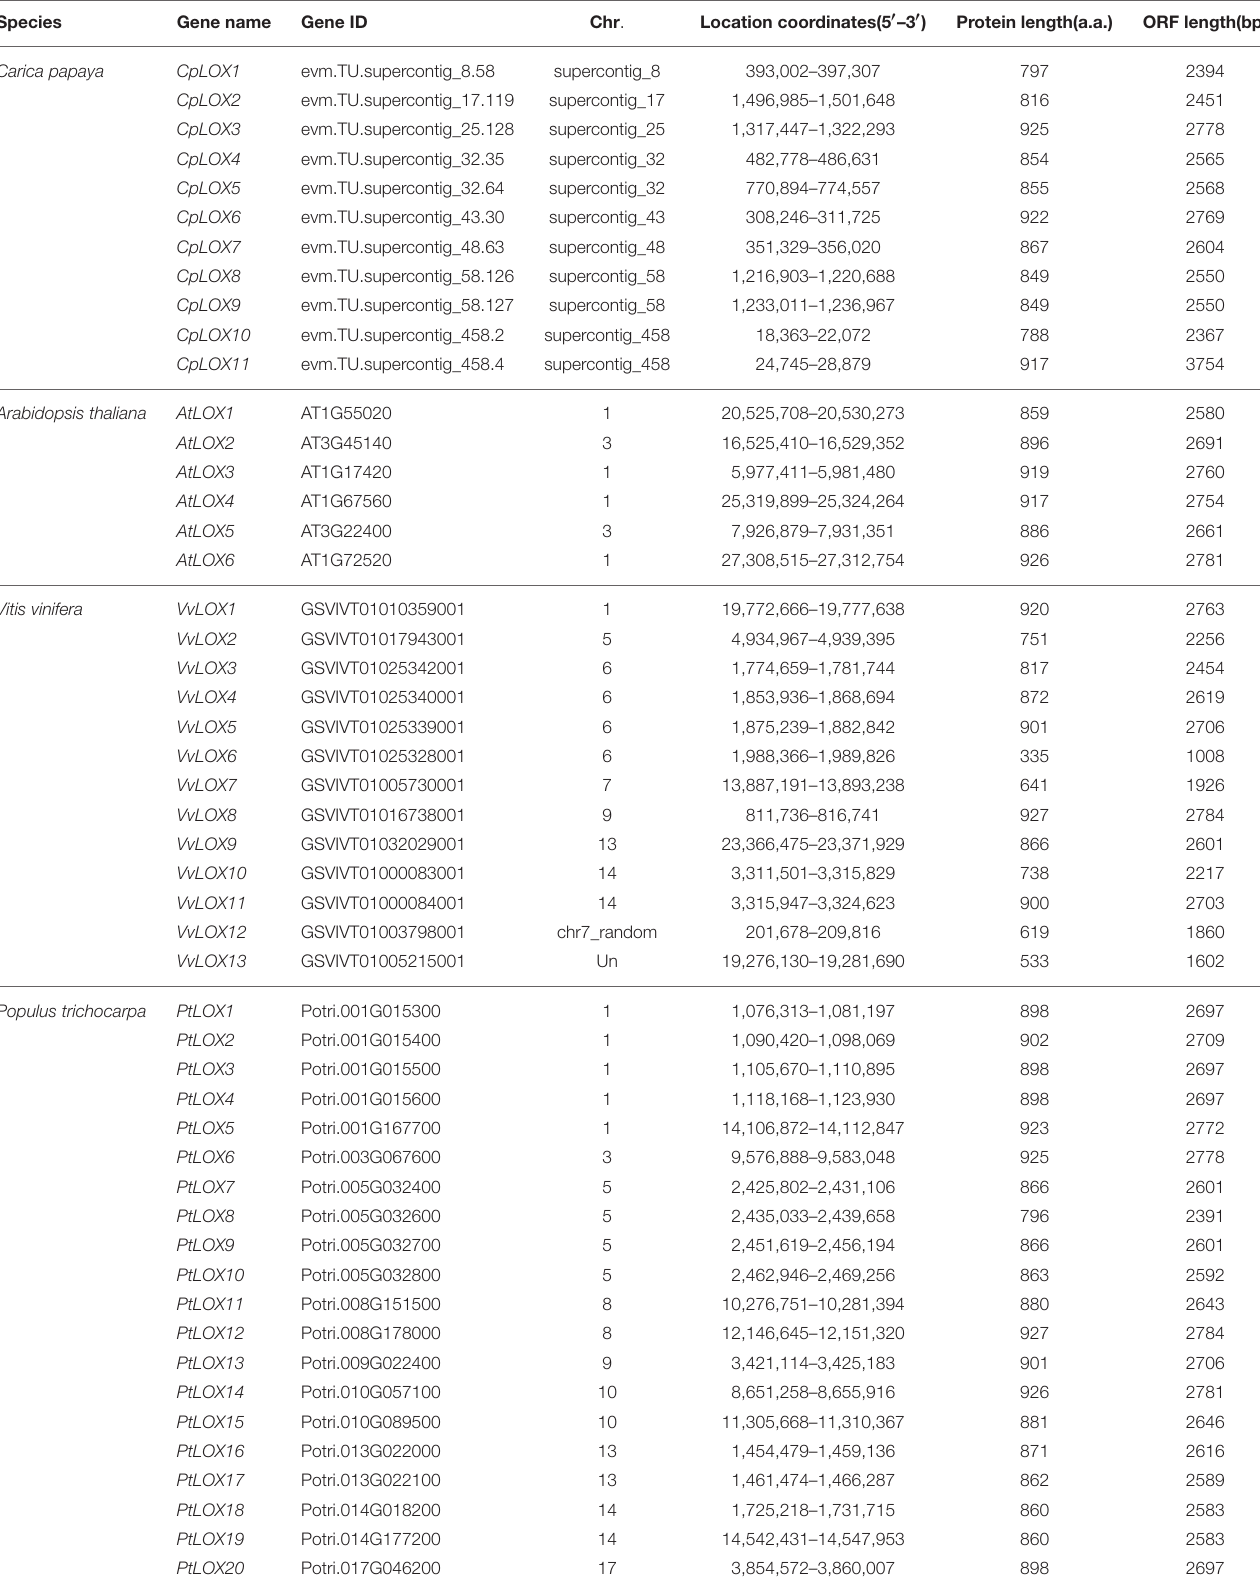
TABLE 1 | Detailed information about the LOX gene family in rosid plants.